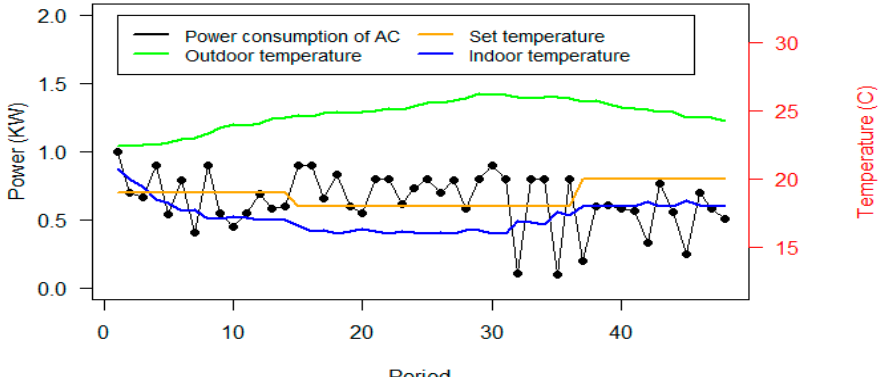
Figure 16. Power consumption of the ACs and thermal parameters of Office #2 on Day #13 in scenario C after 25% increment of comfort parameters.